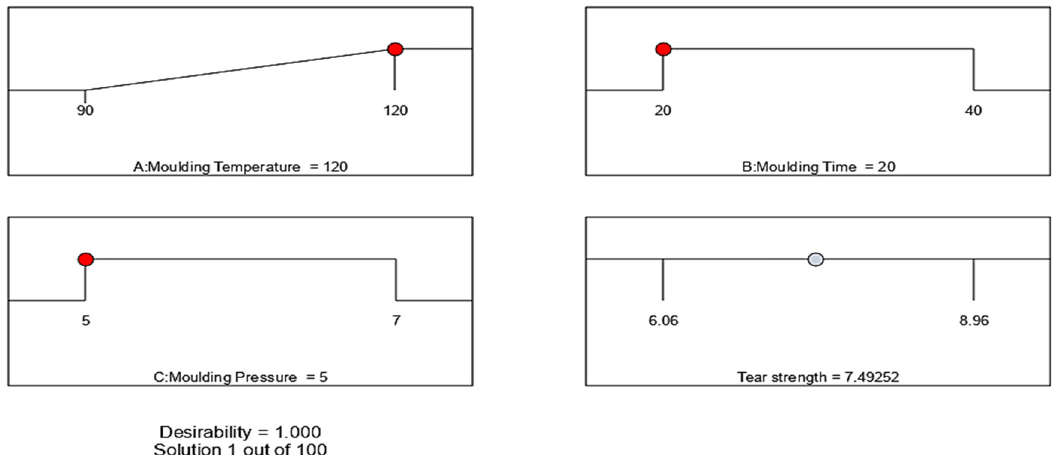
Figure 20: Ramp function graph for tear